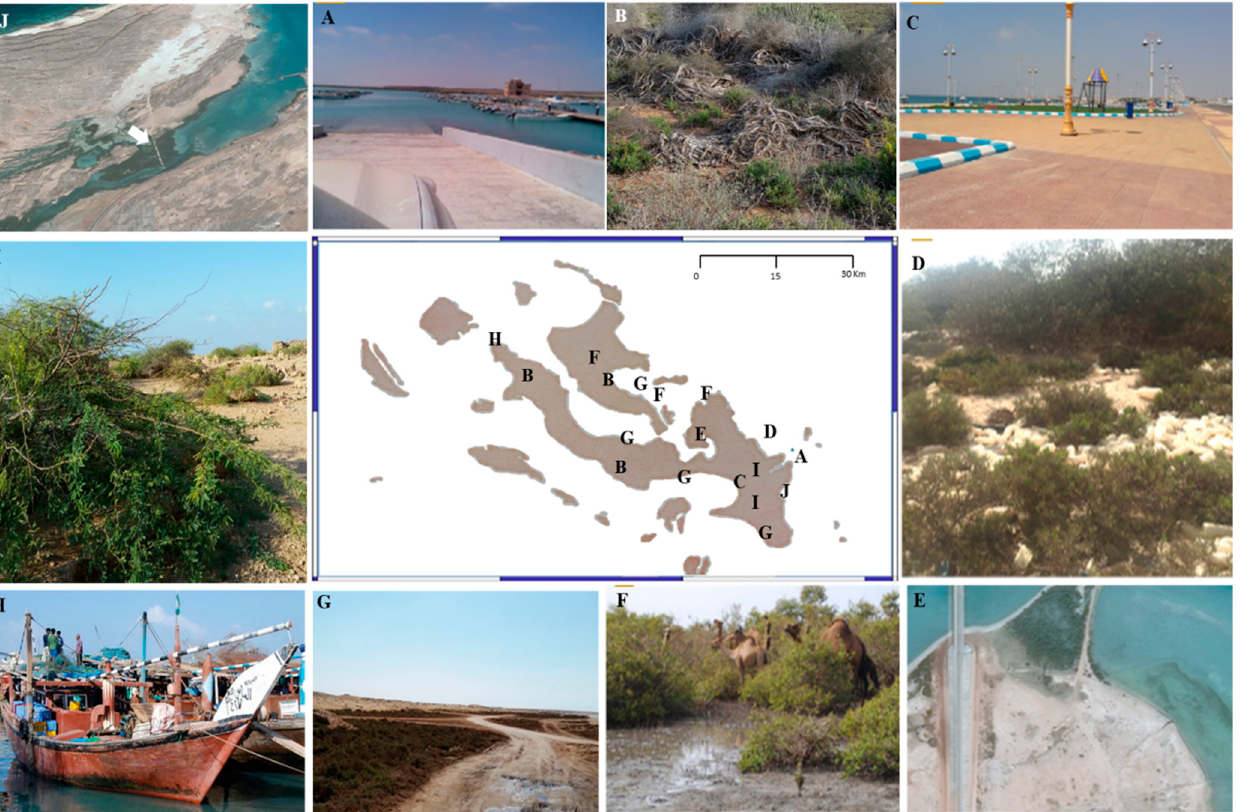
Figure 2. The Farasan Archipelago map of the most threatened areas. ( A ) The Farasan Island port, ( B ) removed Euphorbia collenetteae to convert land for agricultural use and housing construction, ( C ) Jannabah beach gardens, ( D ) waste disposal in A. marina area, ( E ) off-road around and within A. marina population behind Sajid Island Bridge, ( F ) camel overgrazing (SWA), ( G ) off-road around along low-shoreline (mostly of Tetraena spp. habitat). ( H ) Small boats in a fishing area, ( I ) the invasive Prosopis juliflora penetrating Vachellia flava woodland in Al-Muharraq area, south-east Farasan Alkabir. ( J ) New road by the sand dividing the mangroves area into two areas, closing the water channels to the internal part. The authors took all photos except E & J.